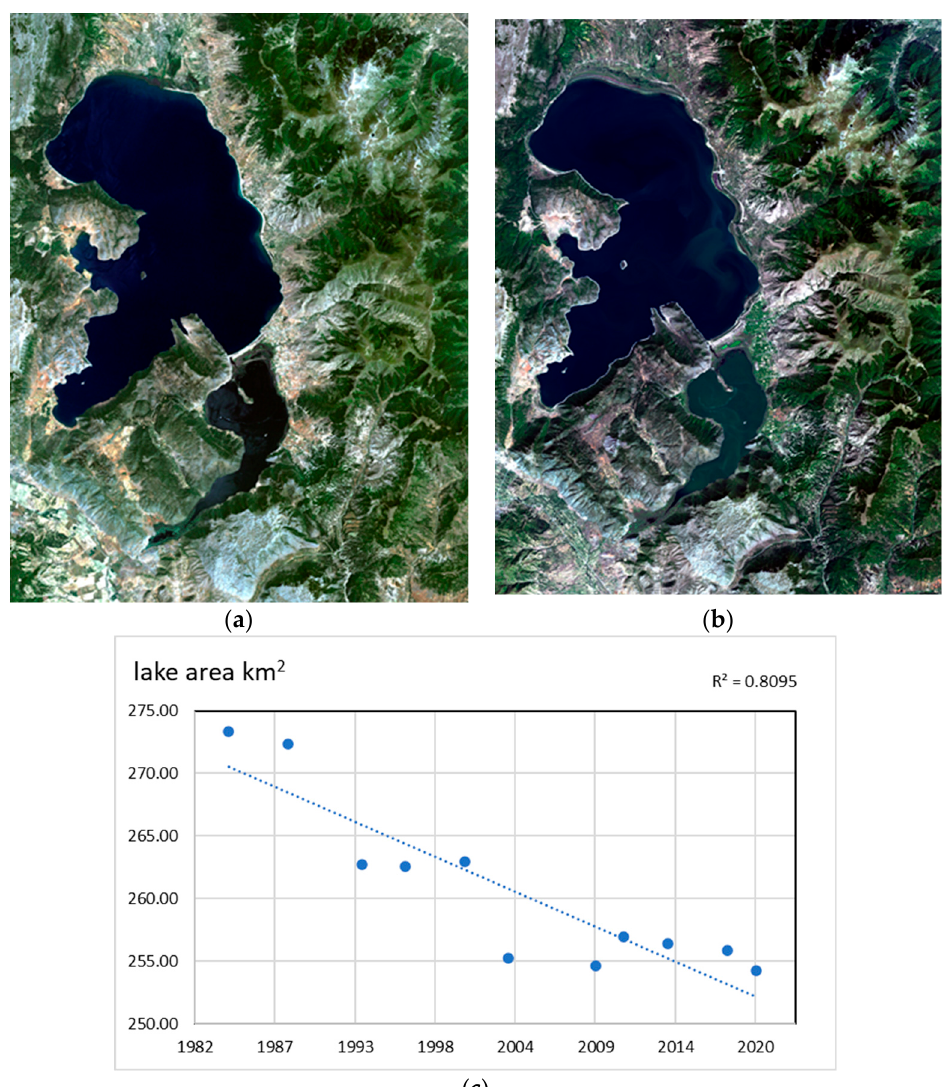
Figure 4. ( a ) Satellite image of Lake Prespa from Landsat 5 in 1984; ( b ) Satellite image of Lake Prespa in 2020 from Landsat 8 imagery; ( c ) Evolution of the lake surface in the period 1984–2020